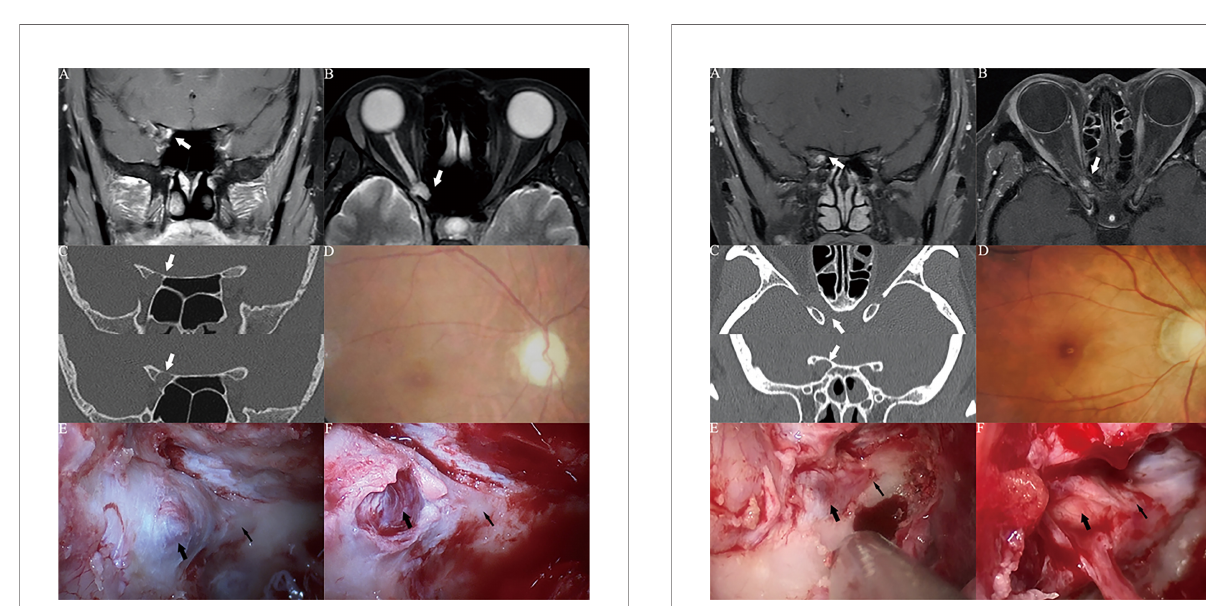
FIGURE 3 | Case1. A 46-year-old female presented with her right eye vision loss for 2 months and sudden loss of right eye vision for 2 weeks. She was misdiagnosed as optic atrophy in the local hospital and was given hormone therapy. (A, B) Optic nerve MRI showed that the right optic nerve sheath occupies, uniformly enhanced, the tumor diameter is less than 1cm (white thick arrow). (C) CT of the optic canal shows that the right optic canal is wider than the left (white thick arrow). (D) Fundus photography shows atrophy of the right optic disc. (E) The right optic canal (black thin arrow) can be seen under the vision of nasal endoscopic surgery, and the space occupying under the optic nerve sheath near the orbital foramen is blue stained. (F) Incision of the optic nerve sheath reveals that a cavernous hemangioma is located under the optic nerve sheath (black thick arrow), behind which is the cranial foramen of the optic canal (black thin arrow).